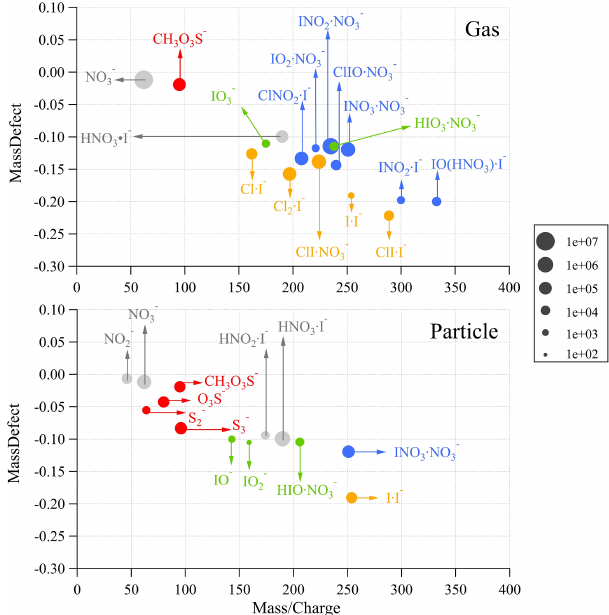
Figure 4. Integrated ion intensities of inorganic molecules and rad- icals in the gas phase (static mode) and particle phase (dynamic mode) measured by the iodide-CIMS in a typical ozonolysis ex- periment. The ions were color-coded according to their elemental composition. For each ion cluster, the parent neutral molecule is on the left-hand side of the middle dot, while the clustering ion I − or NO − is on the right-hand side. Those without a clustering ion are 3 shown as bare